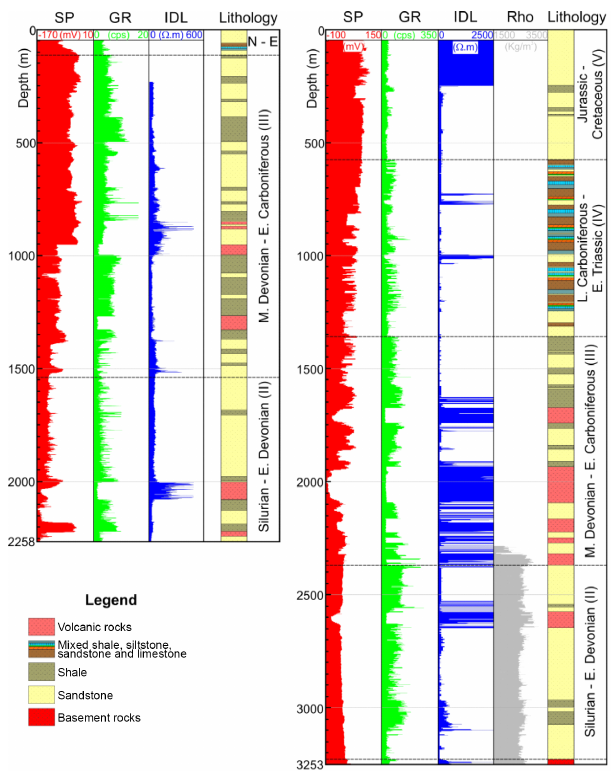
Figure 7. Detailed well-logging curves of exploratory wells 1FL (left) and 2BAC (right). The well tops of the main tectono- sedimentary sequences were defined based on the reference lithos- tratigraphic chart described by Góes and Feijó (1994).